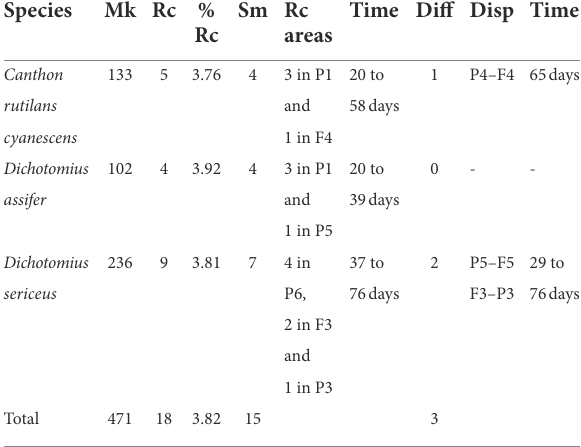
TABLE 1 Number of marked (Mk) and recaptured (Rc) individuals and total recapture rate (% Rc) per species.